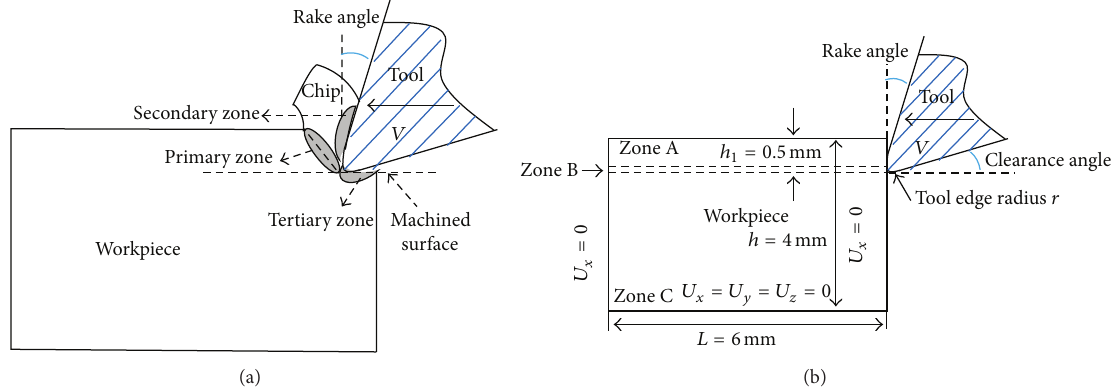
Figure 1: (a) Orthogonal cutting configuration. (b) Decomposition of the workpiece in different zones A, B, and C.